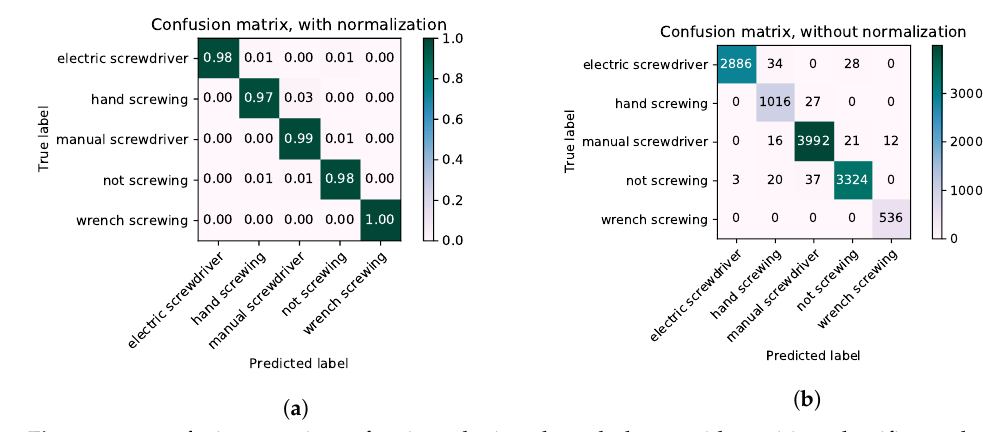
Figure 13. confusion matrices after introducing the rule layer with position classifier and the three activity classifier. ( a ) confusion matrices with normalization. ( b ) confusion matrices with- out